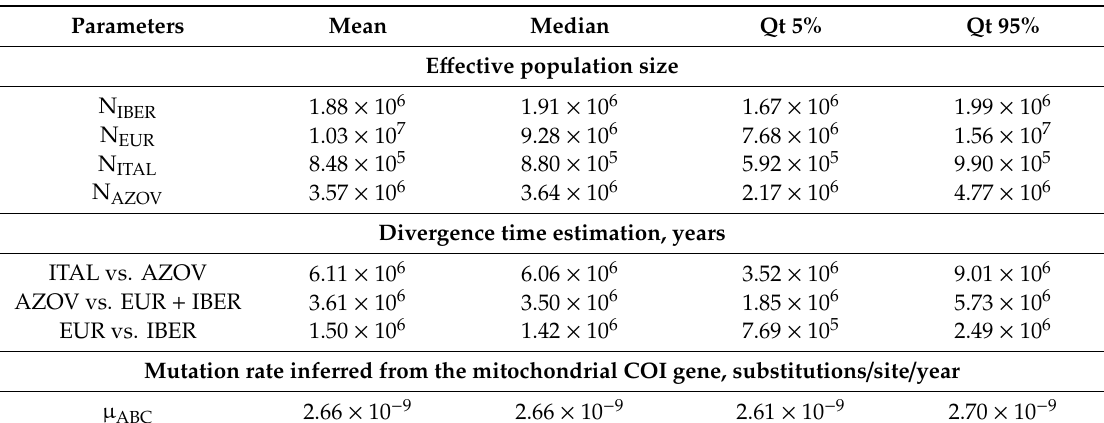
Table 5. Model parameters estimated from posterior distribution of Scenario Sc3 for Anodonta anatina lineages within the ABC